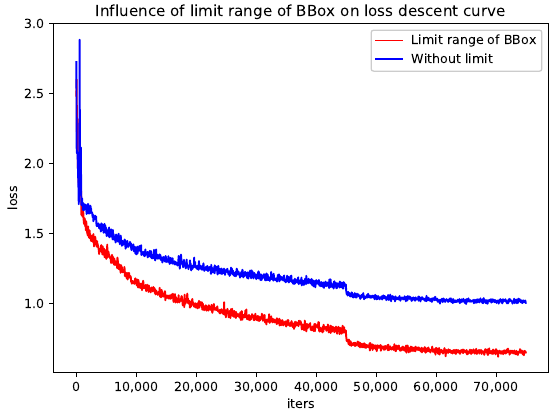
Figure 5. Loss descent curve of baseline.